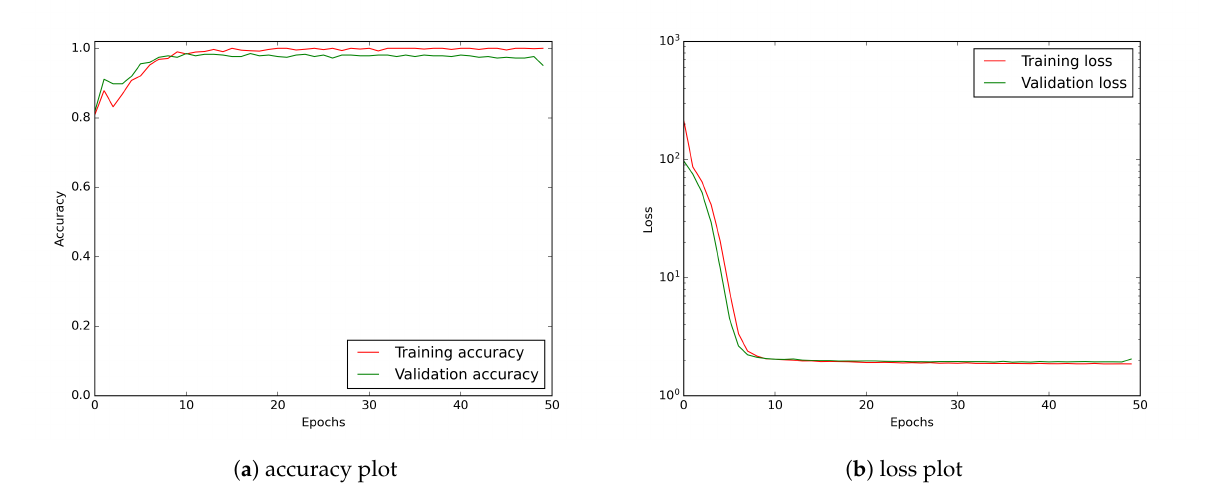
( a ) accuracy plot ( b ) loss plot Figure 10. CNN model learning history showing accuracy and loss curves. A logarithmic scale has been applied to the loss plot to keep a better visibility.